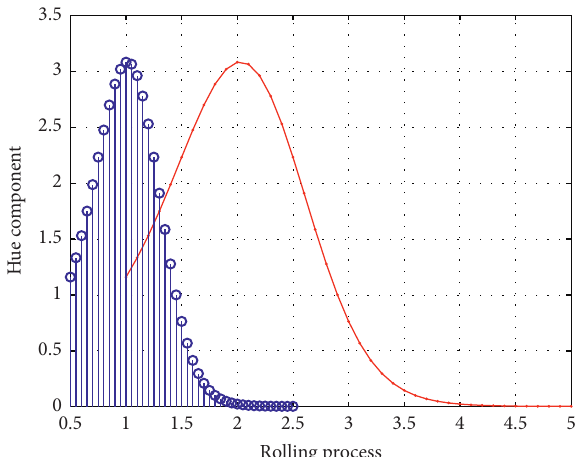
Figure 8: Color histogram of the hue component of the target (b).